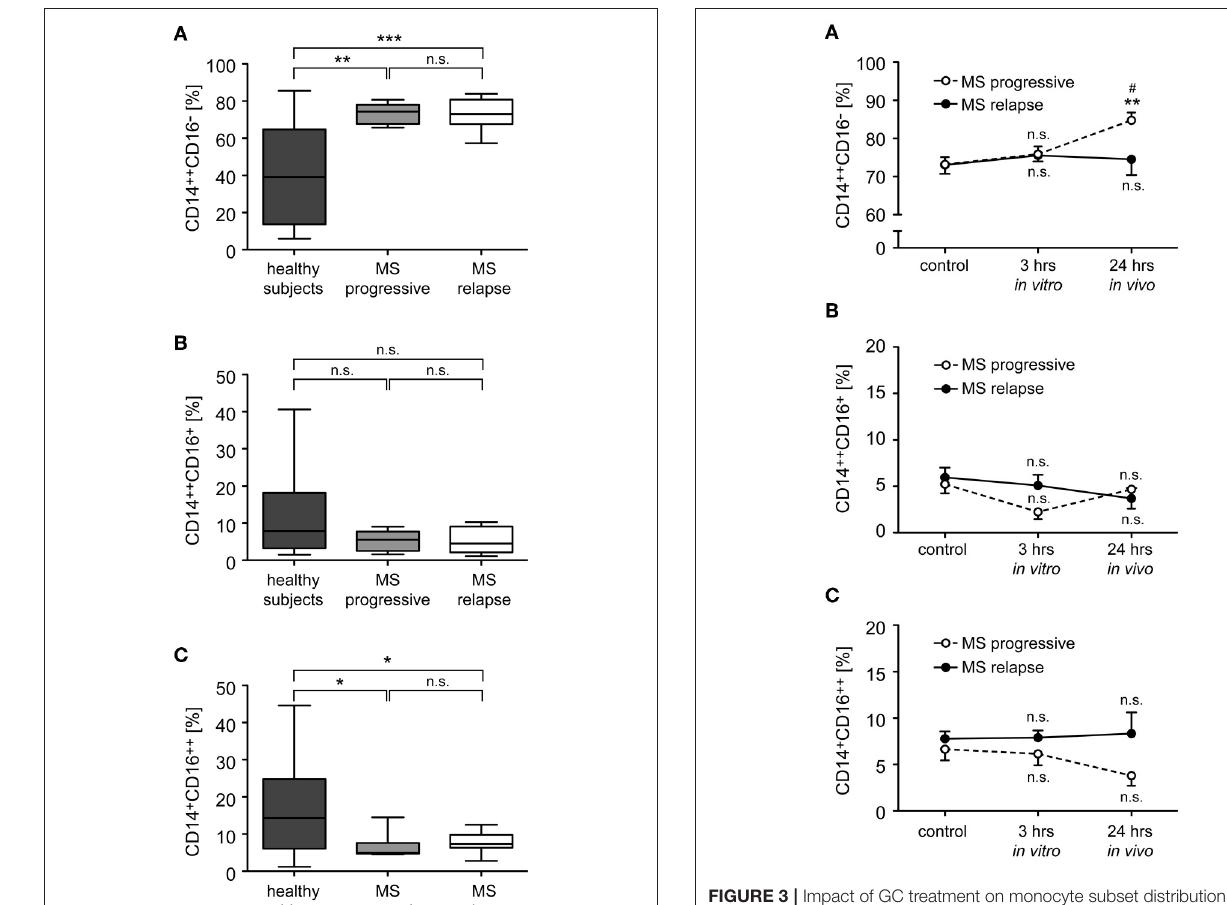
FIGURE 3 | Impact of GC treatment on monocyte subset distribution in MS patients with progressive disease or an acute relapse. Monocytes were isolated from MS patients before MP pulse therapy and incubated for 3h without (control) or with 10 − 6 M MP in vitro . A second blood sample was obtained from the same MS patients 24h after MP pulse therapy in vivo . The percentages of CD14 ++ CD16 − inflammatory monocytes (A) , CD14 ++ CD16 + intermediate state monocytes (B) , and CD14 + CD16 ++ non-classical monocytes (C) were determined by flow cytometry. MS patients were divided into two groups according to their disease activity (progressive, relapse). Data are presented as the mean ± SEM; n = 8 (MS progressive), n = 12 (MS relapse). Statistical analysis was performed using a One-way ANOVA and Newman-Keuls Multiple Comparison test. Levels of significance: n.s. p ≥ 0.05; ** p < 0.01 (control vs. 24h); # p < 0.05 (3 vs.